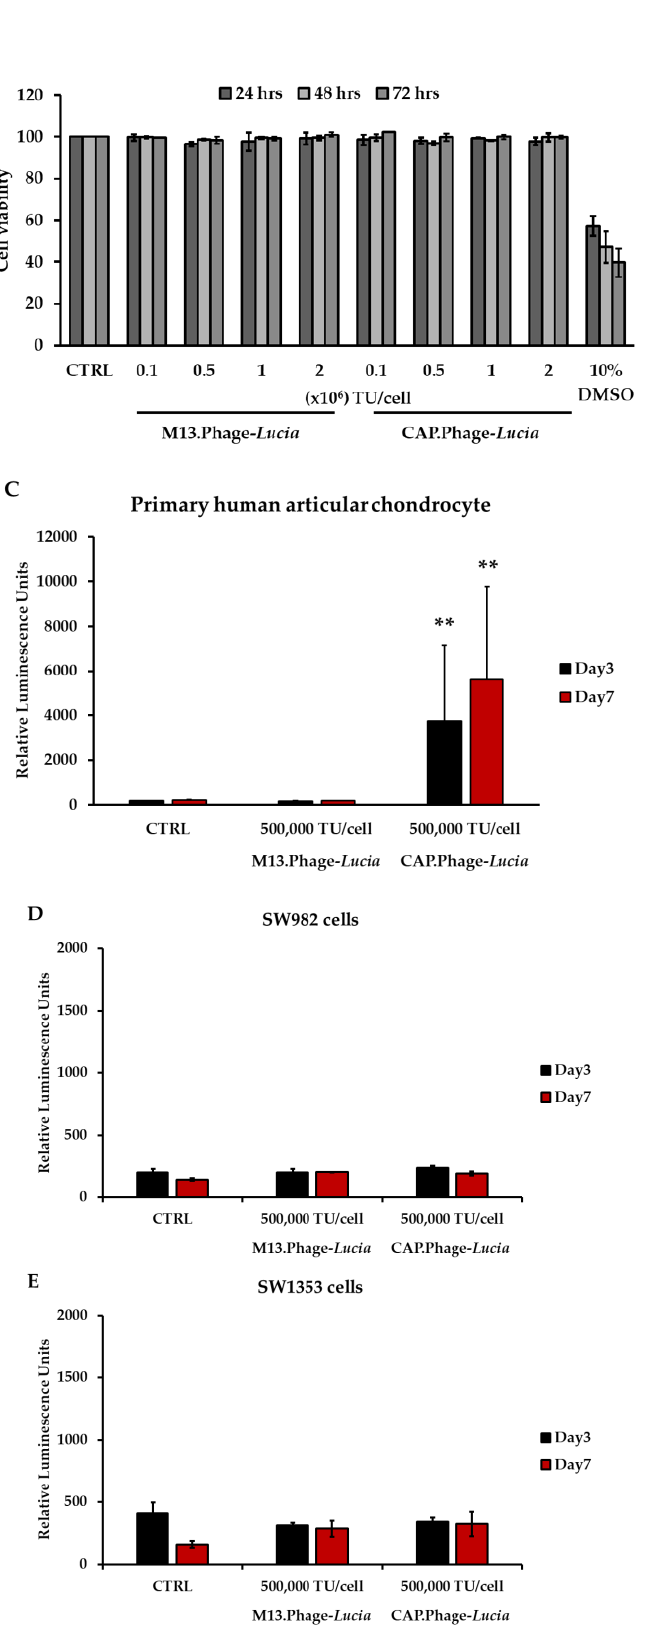
Figure 5. CAP.Phage cytotoxicity analysis on HACs. The cells were treated with CAP.Phage- Lucia and control M13.Phage- Lucia ranging from 0.1 × 10 6 TU/cell to 2 × 10 6 TU/cell for 24 h at 37 °C, then cell viability was measured using the MTT assay ( n = 4) ( A ) and Trypan Blue Exclusion Test ( n = 2) ( B ). Efficacy analysis of CAP.Phage-mediated gene delivery using a secreted luciferase reporter gene on HACs ( n = 6) ( C ), SW982 ( n = 3) ( D ) and SW1353 ( n = 3); the Mann – Whitney Test was used for statistical analysis of cells ( E ). The cells were treated with CAP.Phage- Lucia or M13.Phage- Lucia at 0.5 × 10 6 TU/cell for 24 h at 37 °C. Culture media were replaced with 10%FBS DMEM and incu- bated at 37 °C. At days 3 and 7 post-transduction, the culture media were collected and used to